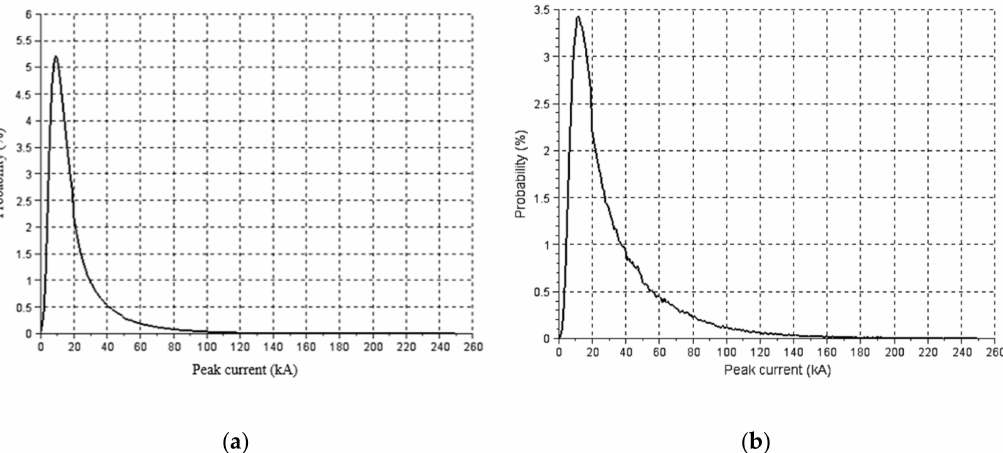
Figure 12. ( a ) Probability distribution of the peak currents of the generated N tot flashes; ( b ) Probability distribution of lightning peak currents impinging the OHL, in percent of the generated flashes.